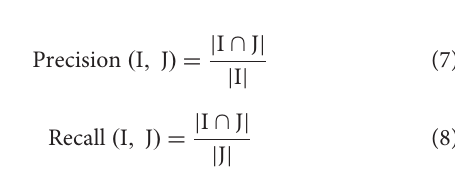
FIGURE 3 | Comparison of the segmentation effect with and without localization. (A) A superposition of the original image and the manually segmented lines. (B) The segmentation result without localization. (C) A superposition of the original image and Mask. (D) The segmentation result with